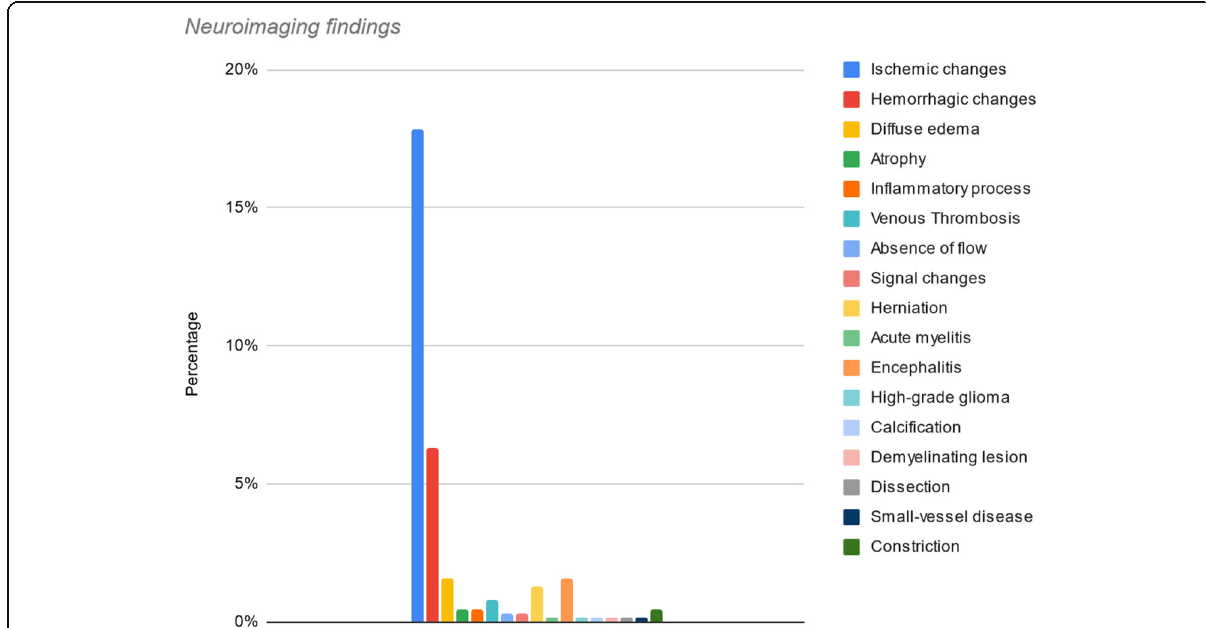
Fig. 2 Evaluation of positive neurological findings on CT scan and MRI of COVID-19 infected patients. To demonstrate positive neuroimaging findings, patients with normal findings on imaging or findings unrelated to COVID-19 were not